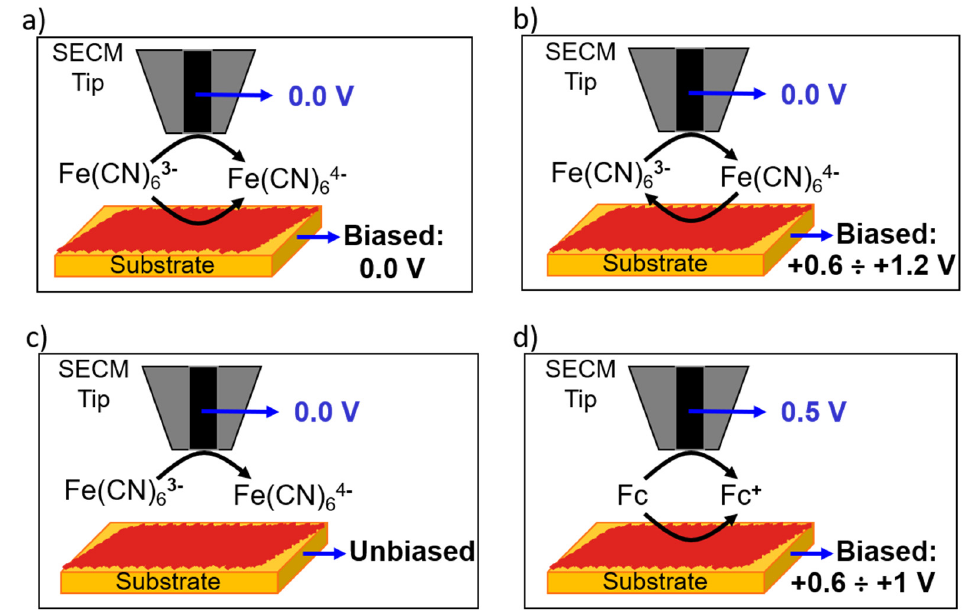
Figure 6. Schemes of the redox processes occurring at the microelectrode tip and substrate at different potentials applied at the substrate. ( a – c ) and ( d ) refer to Fe(CN) 63 − and Fc redox mediator, respectively. Potential applied to the tip and substrate as indicated in the figure.